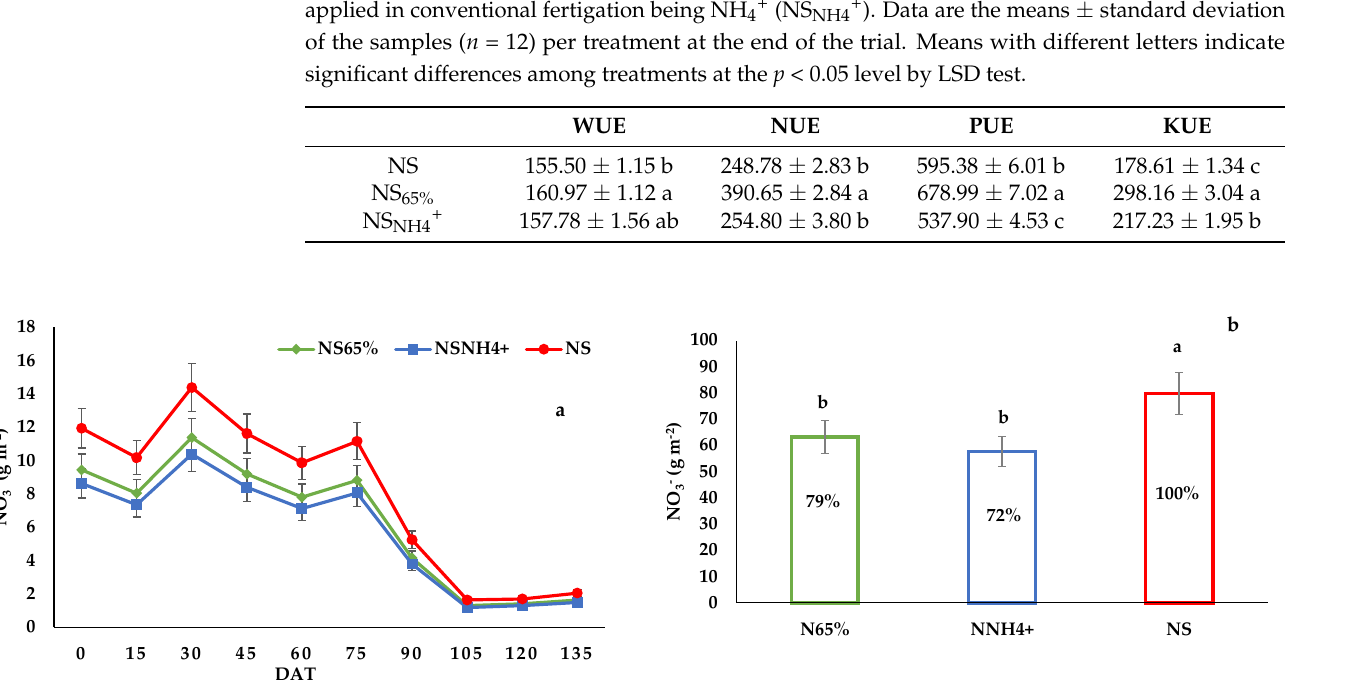
Figure 1. ( a ) Evolution of NO 3 − leaching during the cultivation, ( b ) Total amount of NO 3 − leached by the tomato crop, with the percentage of contamination reduction of the fertigation strategies assayed compared to standard fertigation. The columns show the mean values, and the bars the standard deviation of each treatment ( n = 12) at the end of the trial. Different letters indicate significant differences among treatments at the p < 0.05 level, based on the LSD test.